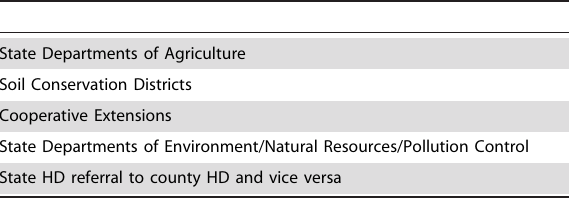
Table 1. Referrals reported by State and County Health Department staff in response to concerns related to